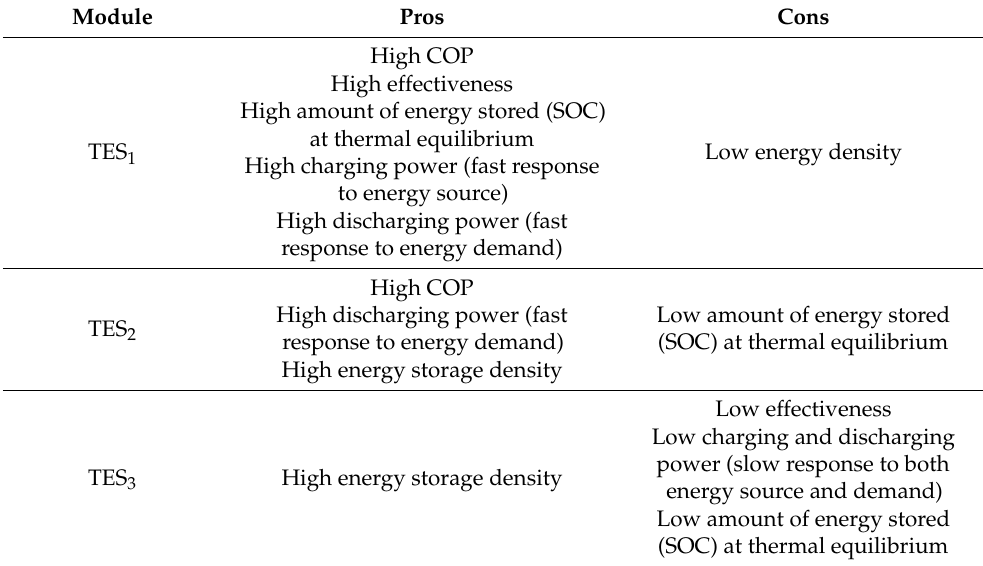
Table 3. Qualitative analysis of the three